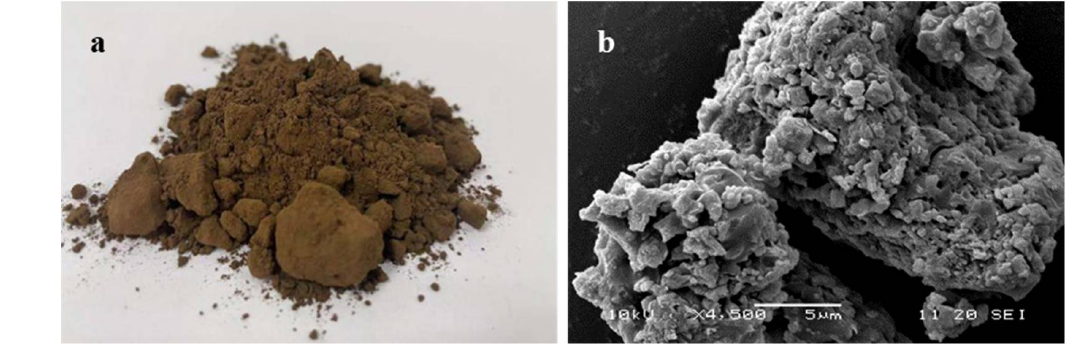
Figure 1. BRA powder ( a ) and its SEM image ( b ). Table 1. Properties of base asphalt.